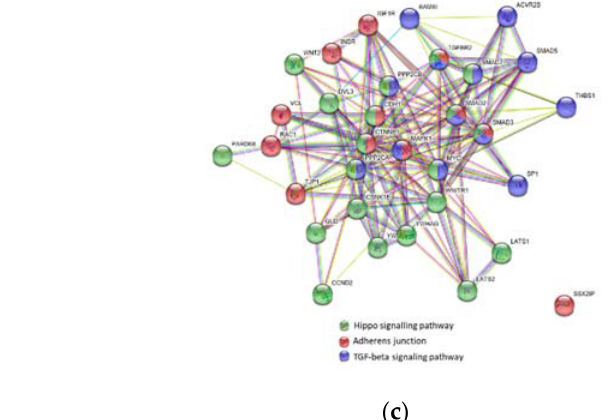
Figure 3. Pathway and target analysis of the miR-320 family. ( a ) Heat map showing Kyoto encyclopedia of genes and genomes (KEGG) pathway analysis of miR-320a, miR-320b and miR-320c using DIANA Tools mirPath v.3 (TarBase v7.0). ( b ) Dissected microRNA (miRNA)-target interactions and functional associations of the three miRs-320 through network- based visual analysis (miRTarBase v8.0) for the identified miRNAs. ( c ) STRING diagram of target protein–protein interaction of the target proteins in Hippo signaling (green bullets), in the transforming growth factor (TGF)- β signaling pathway (blue bullets) and target proteins in the regulation of adherends junction (red bullets). Lines indicate interaction evidence.